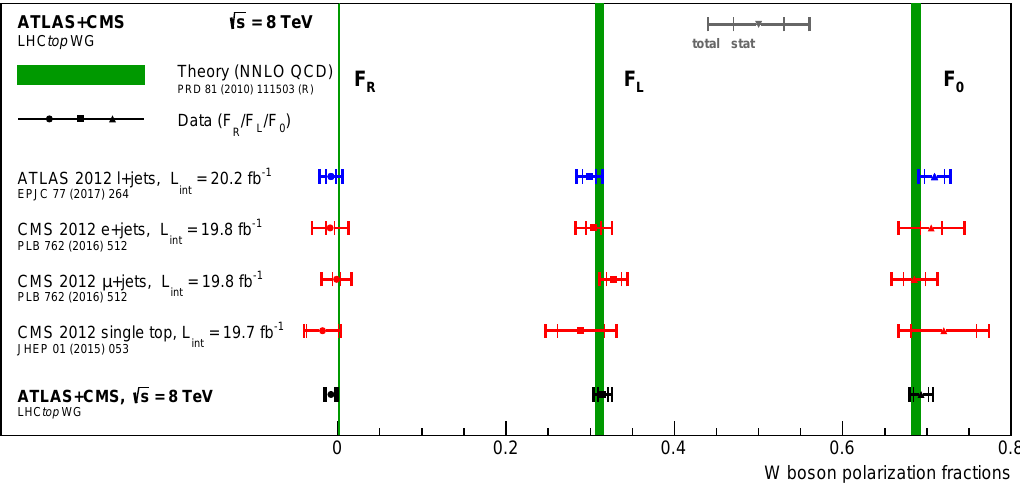
Figure 3: Summary plot of the individual measurements of the W polarization frac- tions and their combination [ 13 ] .